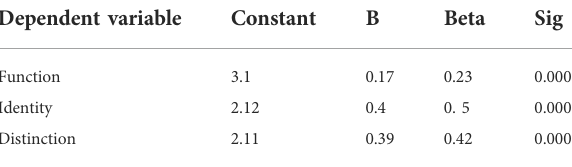
TABLE 8 Regression analysis of the identity function and differentiation on social capital.